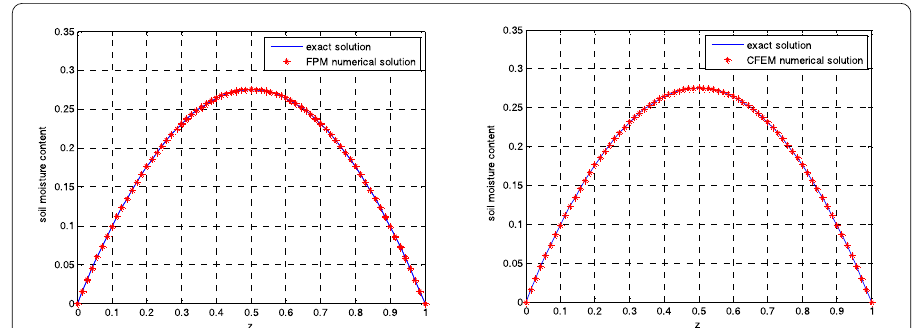
Figure 8 Comparison of results of FPM and CFEM when the node number is 71, (cid:11) t = 0.001 and T = 0.1